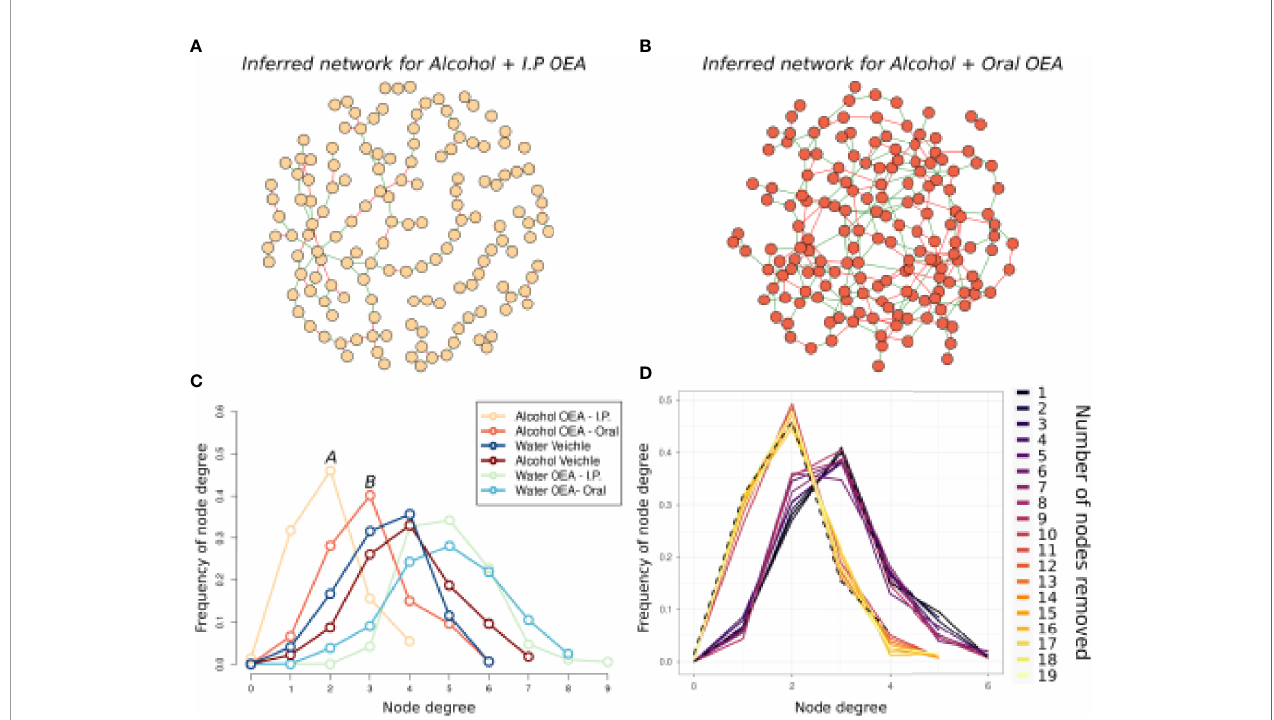
FIGURE 7 | Microbiota association network on the alcohol-intoxicated samples, comparing the oral and i.p. administration routes of OEA. Graphic representation of inferred networks for the i.p. OEA (A) and oral OEA (B) -receiving rat groups, as indicated by the color of nodes and title. The graphical representation of the association network is composed of nodes (i.e., circles) connected by edges (i.e., the segments between nodes). Each node represents an ASV of the community, while each edge represents the presence of a signi fi cant association between two ASVs; there is a positive association when edges are green, while there is a negative association when edges are red. (C) Frequency distribution of the node degree statistic of all the inferred networks. In this representation, we report the frequencies (i.e., % of total) of nodes in the network for each value of node degree (i.e., a statistic representing the number of nodes connected to each node). Each network is represented as a different line, color coded as reported in the legend. (D) Frequency distribution of the node degree statistic in the oral OEA network, during the “ attack ” on node betweenness. This is graphically represented as in (C) , but in this case, a single line for each iteration of the test is represented, and they all represent the oral OEA network from which a node is removed every iteration. Dotted lines represent i) the starting frequency distribution of the “ undisturbed ” oral OEA network (on the right) and ii) the frequency distribution of the i.p. OEA network. Each line represents the frequency distribution of node degree of a different network, reobtained after removal of one node (and recalculation) of the previous network. After the removal of 11 nodes, the frequency distribution of node degree in the oral OEA community resembles well the frequency distribution of the node degree in the i.p. OEA community. Alcohol + oral OEA group, n = 7; alcohol + i.p. OEA group, n = 7.